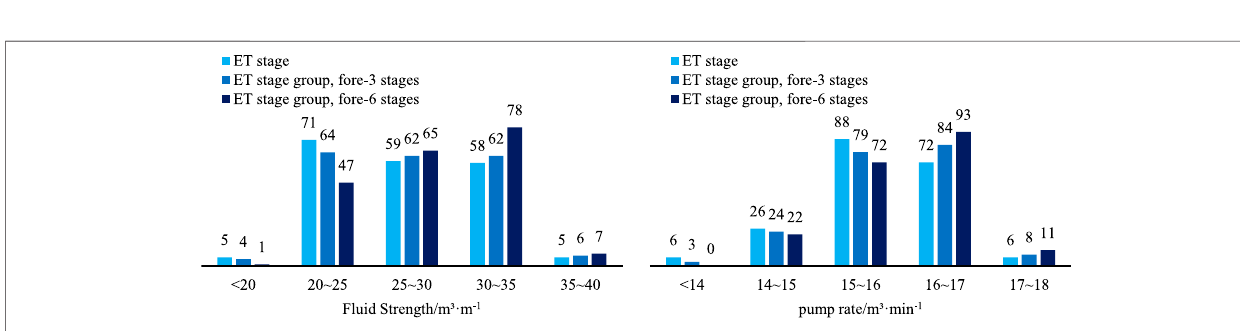
FIGURE 11 | Model diagram of the formation stress state change caused by fracturing.